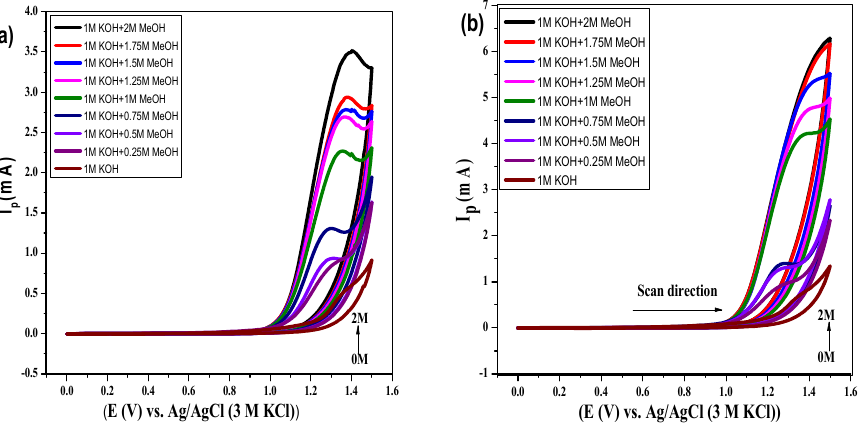
Figure 7. Cyclic voltammograms using equiatomic (Al, Fe, Mg, Cd, Cr, Mn) 3 O 4 ( a ) and non-equiatomic [Al 35 (Fe, Mg, Cd, Cr, Mn) 65 ] 3 O 4 electrodes ( b ) in 1M KOH at 100 mV s − 1 showing variation in peak current with increasing the methanol